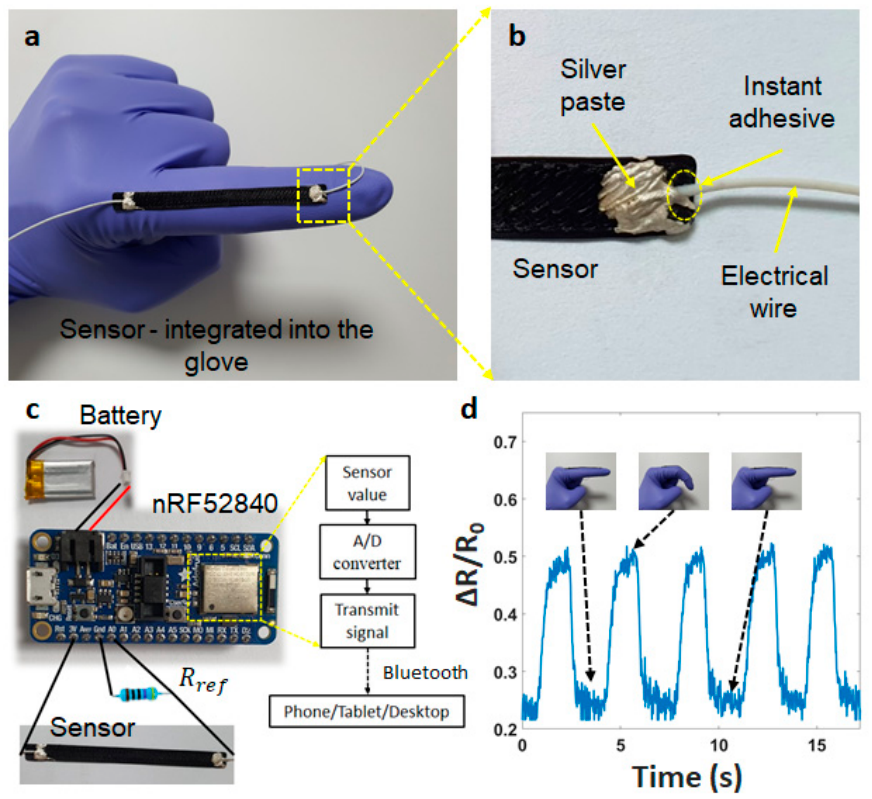
Figure 7. ( a ) Structure of the sensor integrated into the glove, ( b ) Structure of the connection, ( c ) Integrated device, and ( d ) Resistance changes of the finger when bending at 45° and recovering.